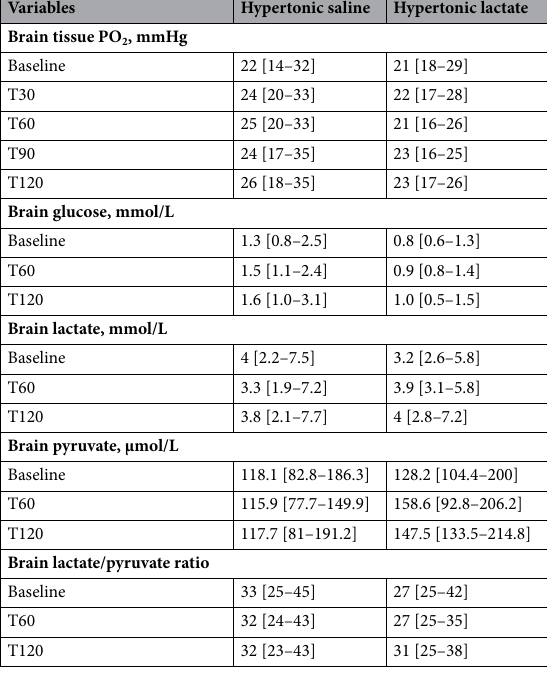
Table 3. Effectiveness of osmotherapy with hypertonic saline vs. hypertonic lactate on brain tissue PO 2 and cerebral energy metabolism. Data are presented as median and interquartile range [25th–75th percentiles].